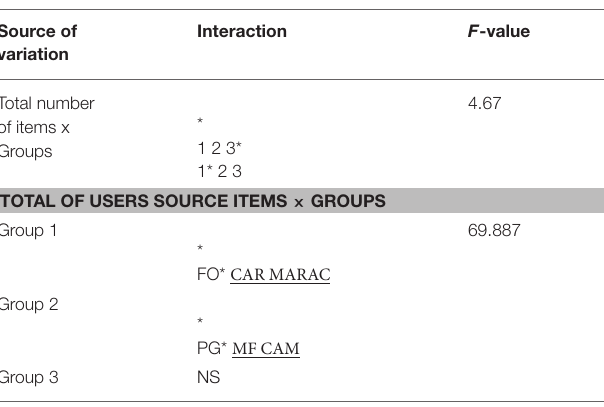
TABLE 4 | Summary of ANOVA analyses for the total number of items, development beach groups, and number of beach